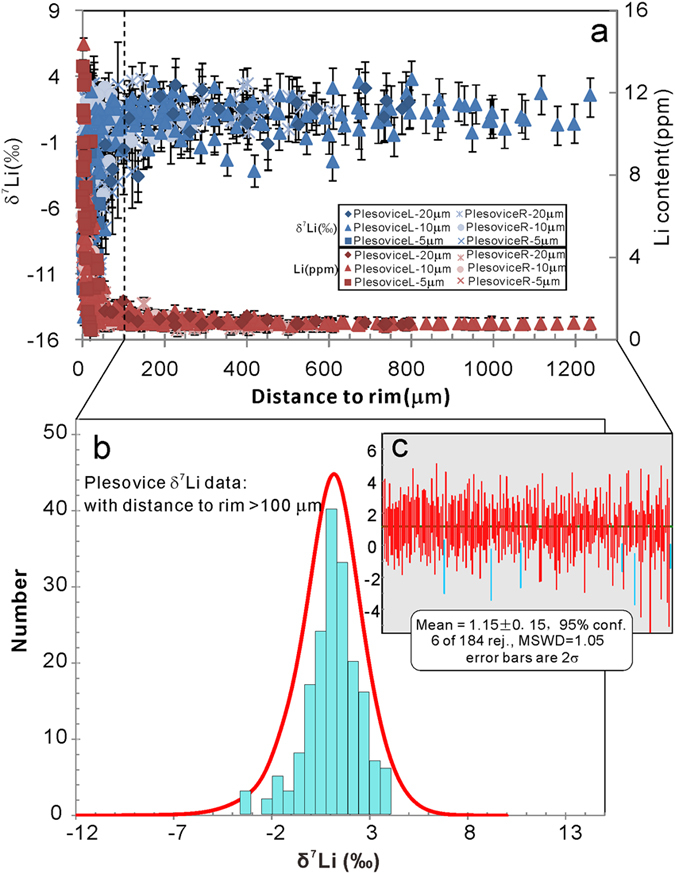
(a) Compiled data for all the analysed spots on the Plešovice zircons. (b) Probability density plot and (c) Weighted average of analysed spots more than 100 μm from the rim.